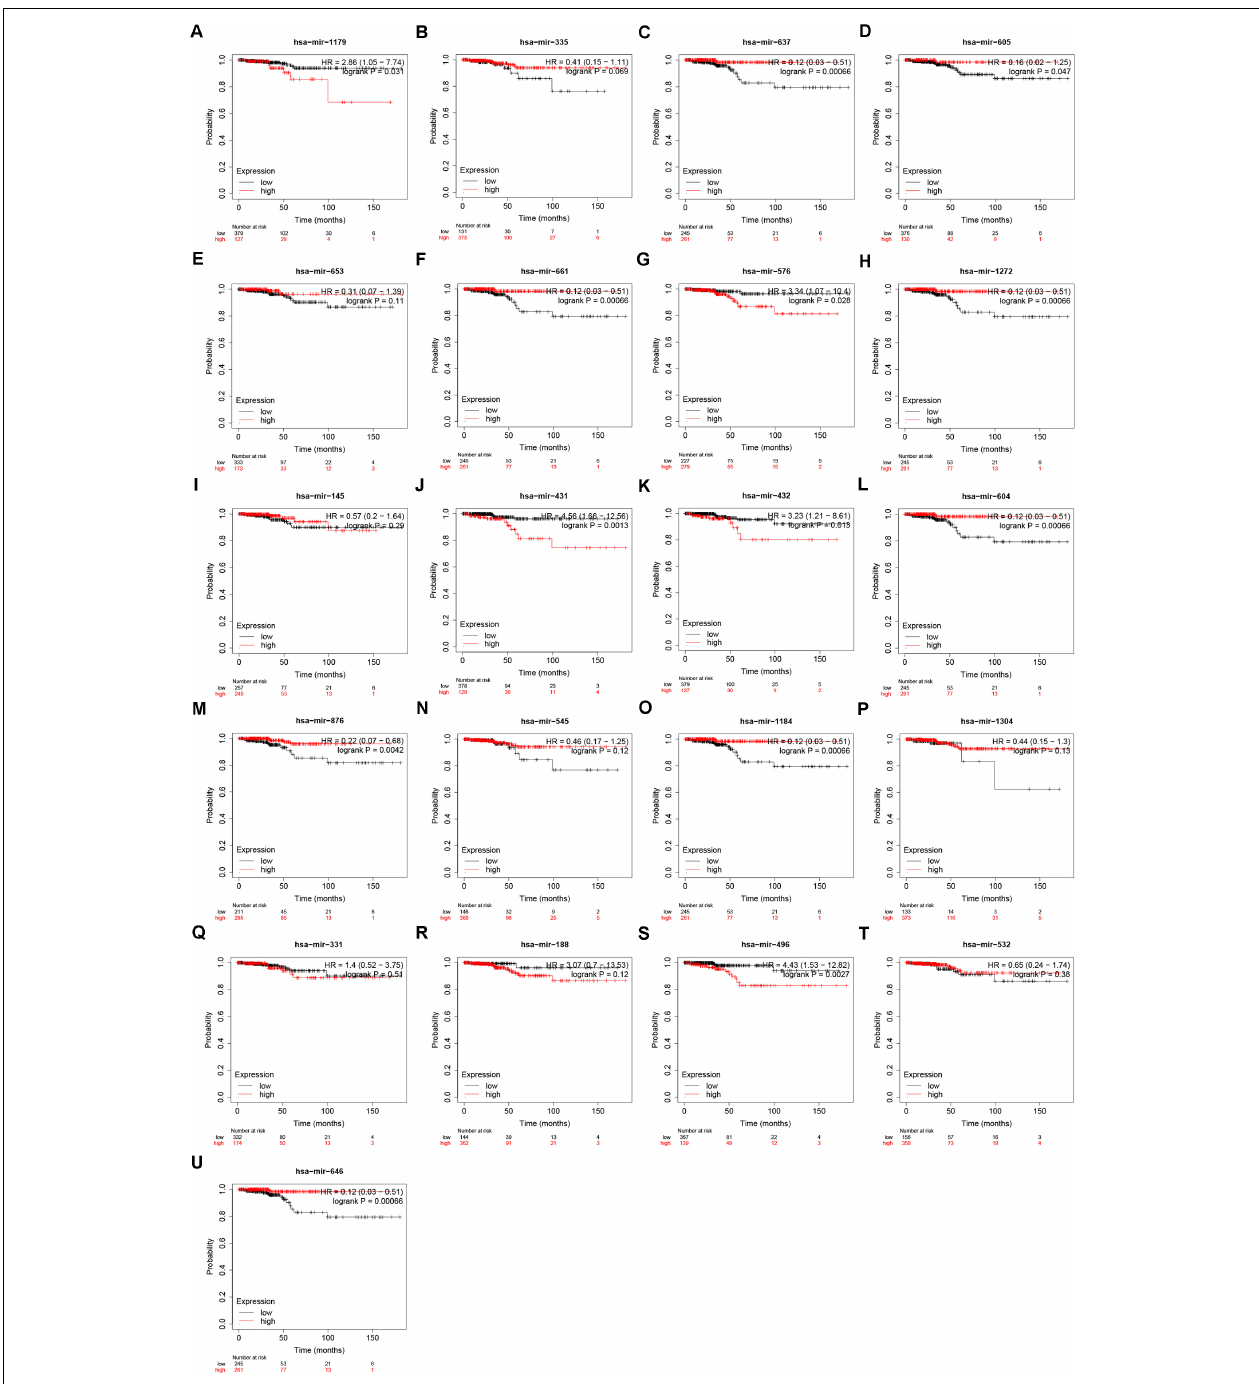
FIGURE 5 | The prognostic values of 21 predicted miRNAs that potentially bind to 9 candidate circRNAs in thyroid carcinoma. (A) The prognostic value of miR-1179 in thyroid carcinoma. (B) The prognostic value of miR-335-5p in thyroid carcinoma. (C) The prognostic value of miR-637 in thyroid carcinoma. (D) The prognostic value of miR-605-5p in thyroid carcinoma. (E) The prognostic value of miR-653-5p in thyroid carcinoma. (F) The prognostic value of miR-661 in thyroid carcinoma. (G) The prognostic value of miR-576-3p in thyroid carcinoma. (H) The prognostic value of miR-1272 in thyroid carcinoma. (I) The prognostic value of miR-145-5p in thyroid carcinoma. (J) The prognostic value of miR-431-5p in thyroid carcinoma. (K) The prognostic value of miR-432-5p in thyroid carcinoma. (L) The prognostic value of miR-604 in thyroid carcinoma. (M) The prognostic value of miR-876-3p in thyroid carcinoma. (N) The prognostic value of miR-545-3p in thyroid carcinoma. (O) The prognostic value of miR-1184 in thyroid carcinoma. (P) The prognostic value of miR-1304-3p in thyroid carcinoma. (Q) The prognostic value of miR-331-3p in thyroid carcinoma. (R) The prognostic value of miR-188-3p in thyroid carcinoma. (S) The prognostic value of miR-496 in thyroid carcinoma. (T) The prognostic value of miR-532-3p in thyroid carcinoma. (U) The prognostic value of miR-646 in thyroid carcinoma. “logrank P < 0.05” represents significant difference.